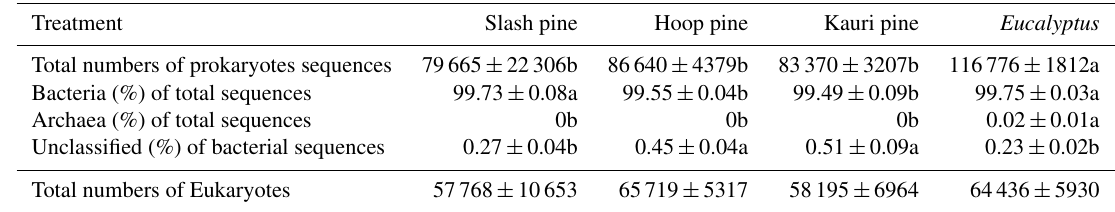
Table 2. Selected statistics of the Miseq sequencing output from 78-year-old forest plantations with different tree species. Treatment Slash pine Hoop pine Kauri pine